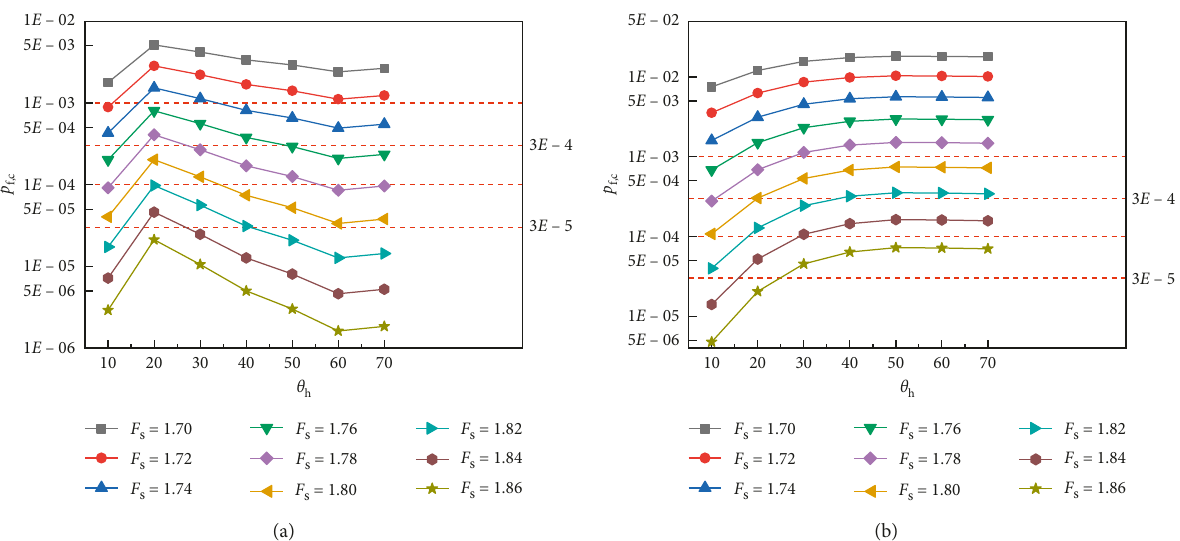
Figure 11: Probability of compression failure of tunnel liner under different random fields as a function of the horizontal correlation length and factor of safety: (a) CRF and (b) URF.